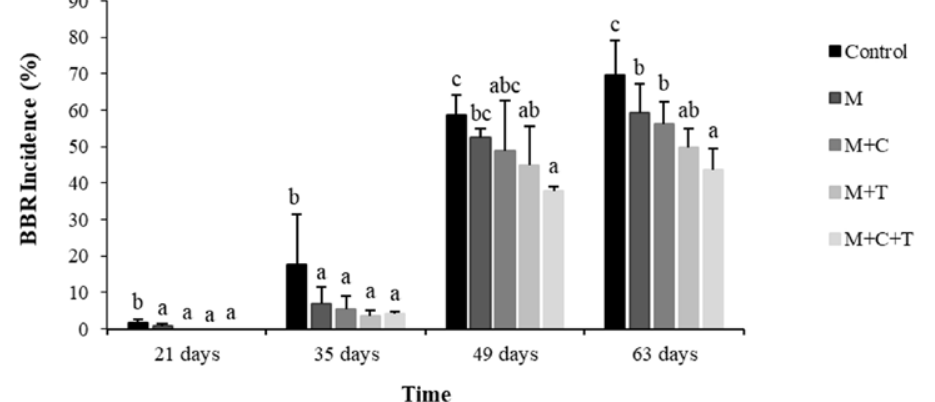
Fig. 1. Basal bulb rot incidence on shallot 21 until 63 days after treatment by mulch, mulch plus compost, mulch plus Trichoderma asperellum , and mulch plus compost plus T. asperellum M = mulch, C = compost, T = T. asperellum. Means of incidence at the same time, followed by the same letter are not significantly different according to DMRT (p ≤ 0.05). Vertical bars show standard errors of means.